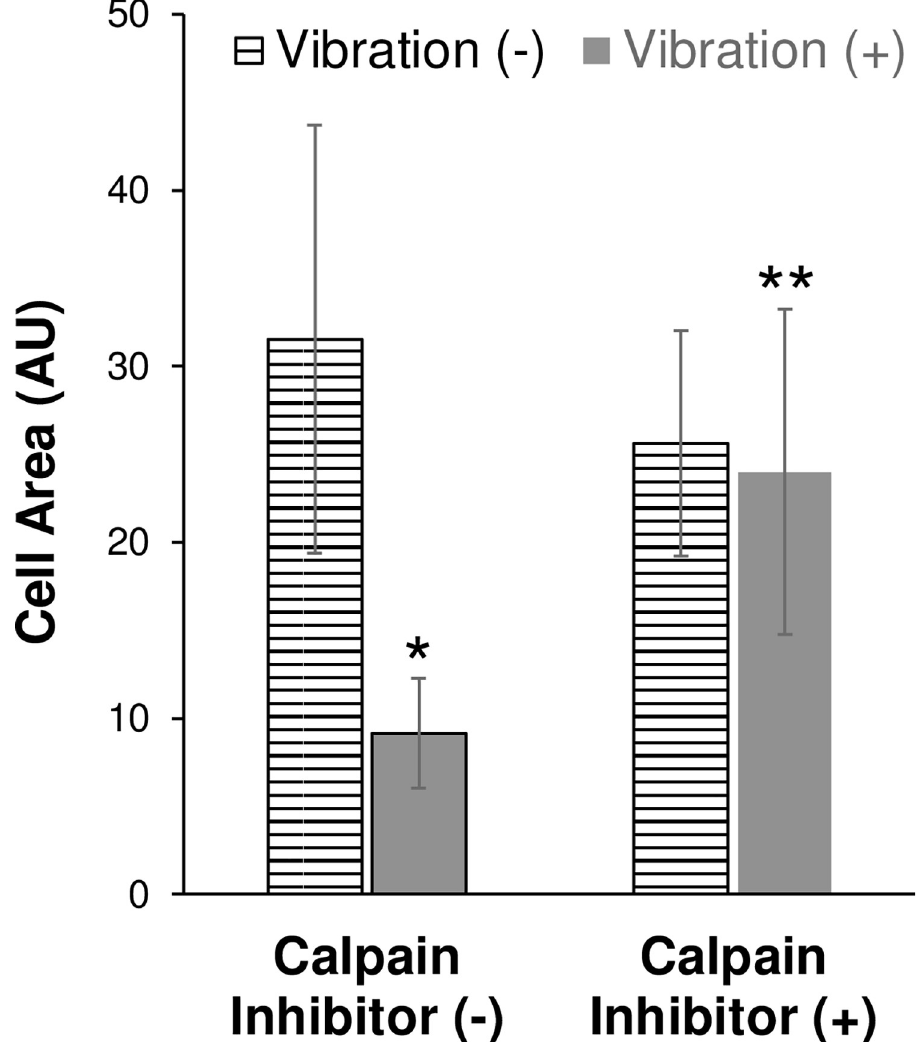
Fig 5. Inhibition of calpain activity attenuates vibration induced cell shape change. HeLa cells were pre-treated overnight with DMSO (solvent control) [calpain inhibitor (-)] or with calpain inhibitor, PD150606 [calpain inhibitor (+)]. HeLa cells were washed and re-treated immediately prior to treated without vibration (-) [striped bar] or with vibration (+) [solid bar]. The perimeter of each cell ( � 100) was delineated including any protrusions and the cell area was measured (AU). Data shown as average cell area (AU) for all cells measured ( ± sem for three independent experiments). � = p < 0.05 Vibration (+)/Calpain(-) [solid bar] vs. Vibration (-)/Calpain(-) [striped bar]. �� = p < 0.05 Vibration (+)/Calpain Inhibitor (+) vs. Vibration (+)/Calpain Inhibitor (-). No significant difference was noted between Vibration (+)/Calpain Inhibitor (+) and other sample groups [Vibration (-)/Calpain Inhibitor (+) or Vibration (-) / Calpain Inhibitor